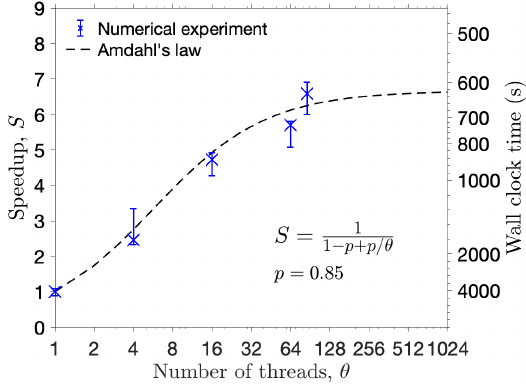
Figure 6. Left y axis: UBER code speedup, defined as the ratio be- tween wall clock time of serial and parallel executions, as a function of parallel threads for solving Problem 1 in spherical coordinates. Each data point (cross) is the median from eight independent and identical numerical experiments, with the associated error bar cov- ering the range of those eight experiments. The dashed line gives a fit to the data points using Amdahl’s law with parameter p = 0 . 85 (see text for its meaning). The right y axis marks the actual wall clock time in seconds for the numerical experiments on a Linux server with a maximum of 86 CPUs (the rightmost data point) at 2.1GHz of floating-point operation frequency per